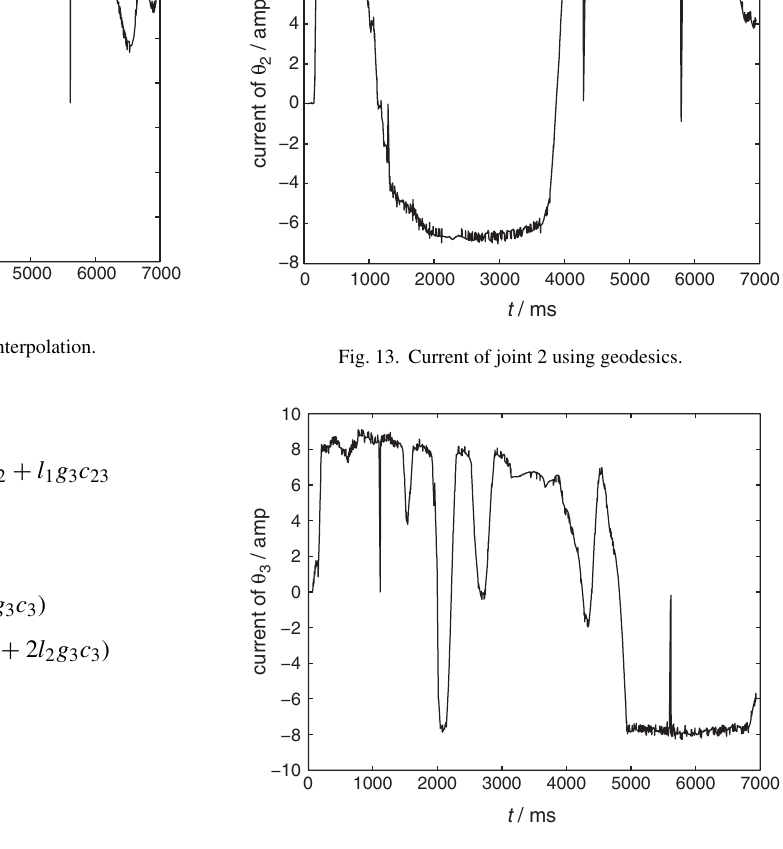
Fig. 12. Current of joint 2 using interpolation.